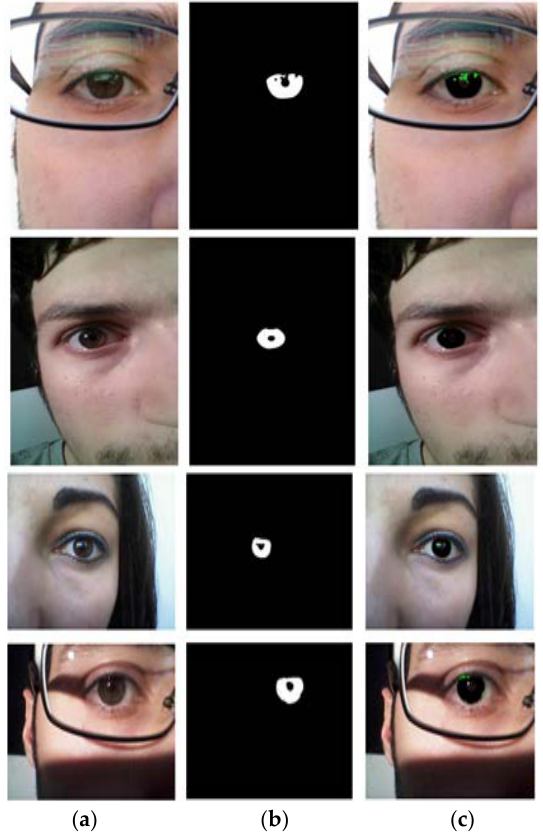
Figure 14. Examples of correct segmentation results in MICHE-I database by our method. ( a ) Original image. ( b ) Ground-truth image. ( c ) Segmentation result by IrisDenseNet (The false and negative errors are presented as green and red, respectively. The true positive case is presented as black).